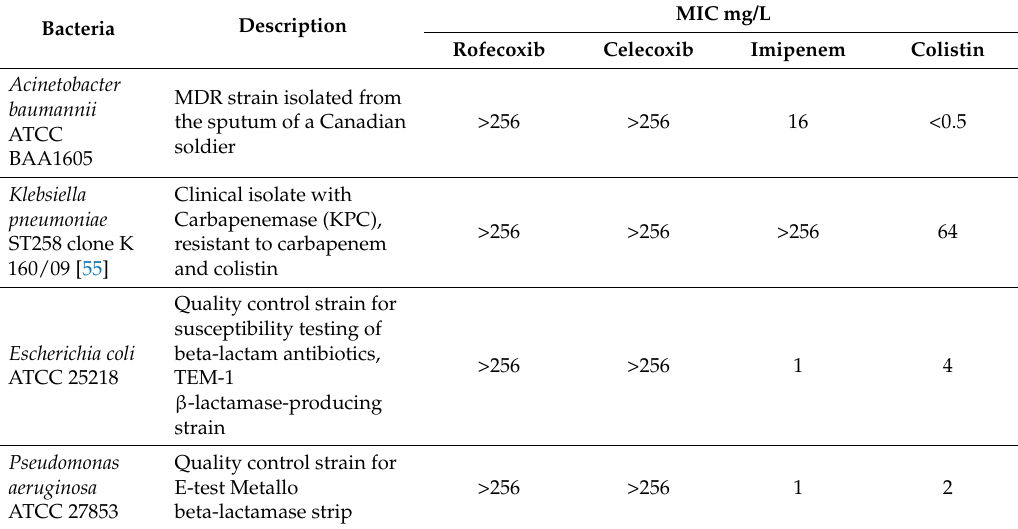
Table 3. MIC of celecoxib and rofecoxib against Gram-negative